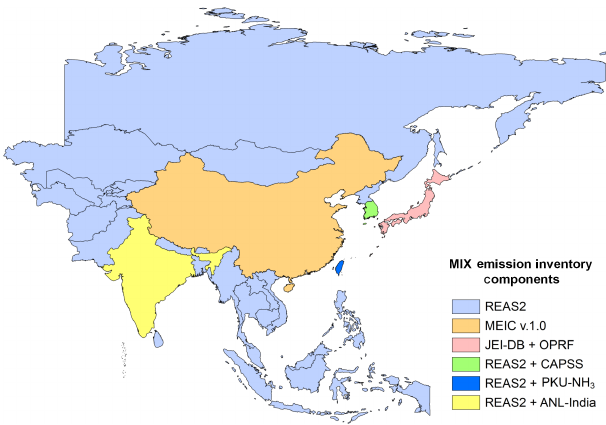
Figure 1. Domain and component of the MIX emission